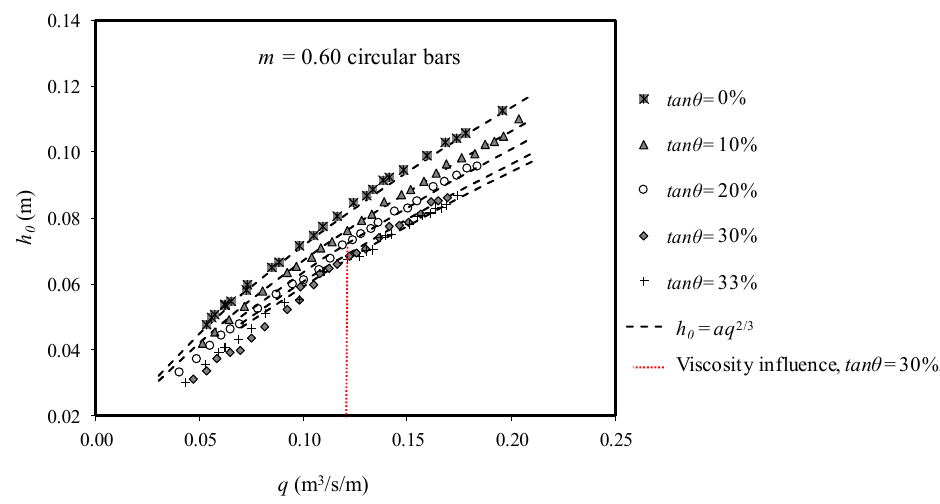
Figure 8. Flow depth at the beginning of the rack h 0 as a function of the incoming flow q . Circular bars with void ratio m = 0.60.